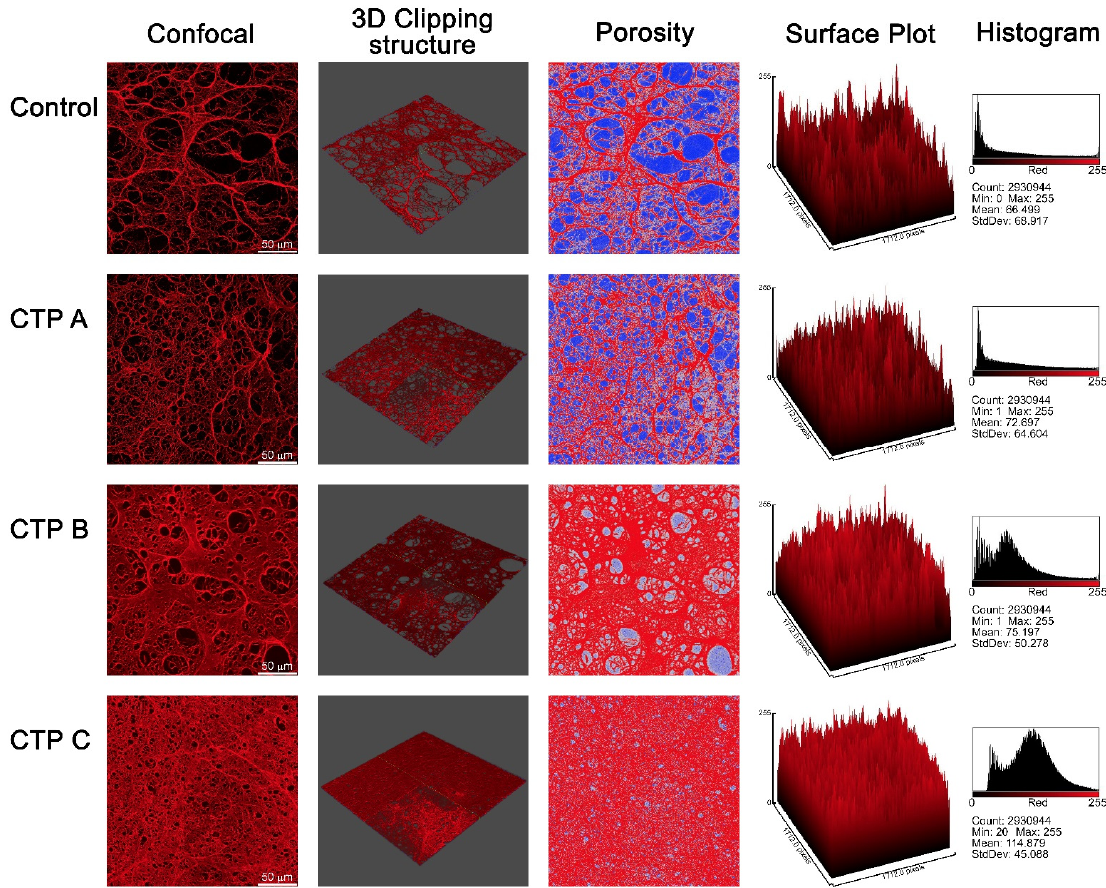
Figure 5. Confocal microscopy analysis of fibrin gels of fibrinogen purified from patients with liver cirrhosis at different stages and controls. Three-dimensional confocal microscopy images clearly show control fibrin gel characterized by large pores and tick fibers when compared to fibrin from cirrhotic patients which are much dense, with narrow pores and thin fibers. In particular, fibrin gels from fibrinogen purified from CTP B and CTP C patients exhibited a dramatic gel rearrangement: fibers were so closely packed in the bulk of gel, obscuring the individual fibers and producing thin sheets with small pores. Surface plot and histogram values are referred to in the corresponding confocal image (first